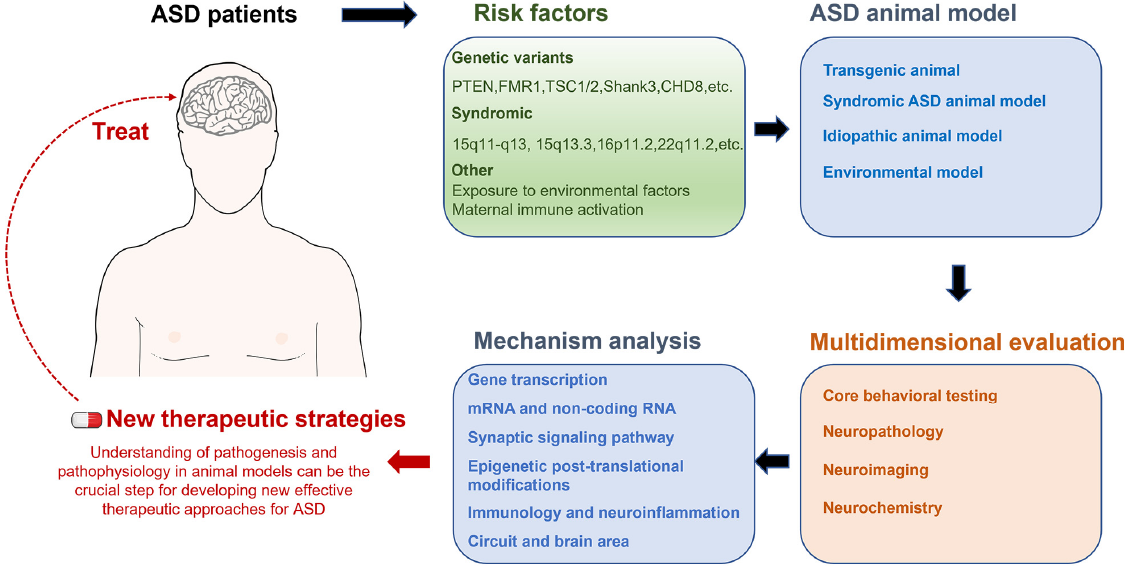
Figure 1. Translation cycle of ASD research. Epidemiological studies of ASD patients can identify abnormal genes and underlying risk factors, including genetic mutations, copy number variations (CNVs), environmental exposures, and maternal immune activation during pregnancy. Based on these data, different animal models will be developed and characterized for their variations. A comprehensive analysis of animal models combined with human pathology to understand the pathogenesis of ASD holds promise as a new therapeutic strategy to feed back to patients.